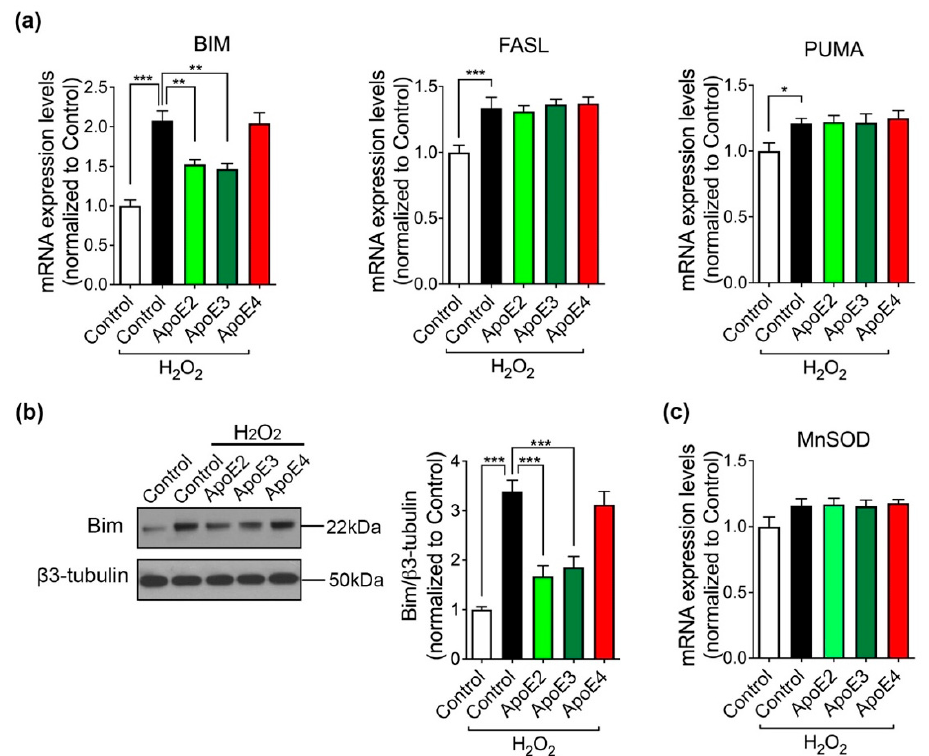
Figure 6. Investigations of FoxO3a downstream targets. ( a ) qRT-PCR of FoxO3a downstream pro- apoptotic targets, including BIM , FASL , PUMA . ( b ) Western blot analysis of Bim protein alterations caused by H 2 O 2 and ApoE. ( c ) mRNA level of MnSOD was assessed by qRT-PCR. n = 4 per line, data are presented as a summary of all lines (mean ± SEM) using one-way ANOVA and Dunnett test. * p < 0.05, ** p < 0.01, *** p < 0.001 versus neurons co-treated with control medium. * p < 0.05, ** p < 0.01, *** p < 0.001 versus neurons co-treated with control